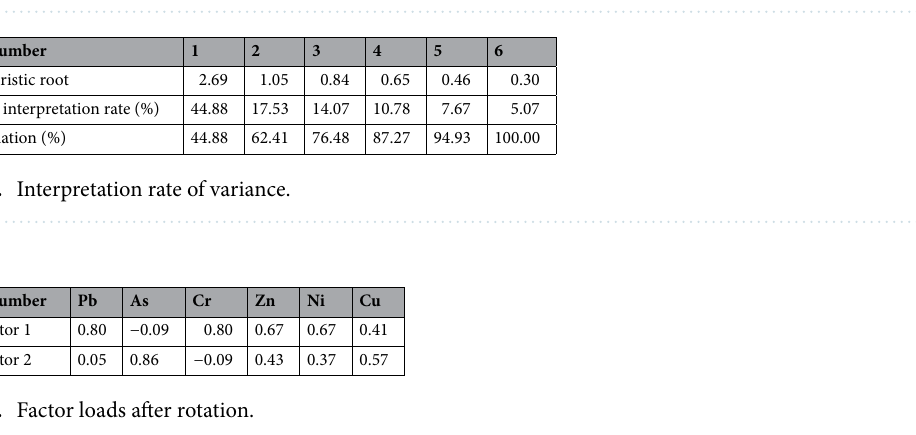
Figure 3. Pearson coefficient correlation of soil heavy metals: blue from light to dark represents the correlation from low to high. (Note: SPSS 26.0 was used to create this figure.)